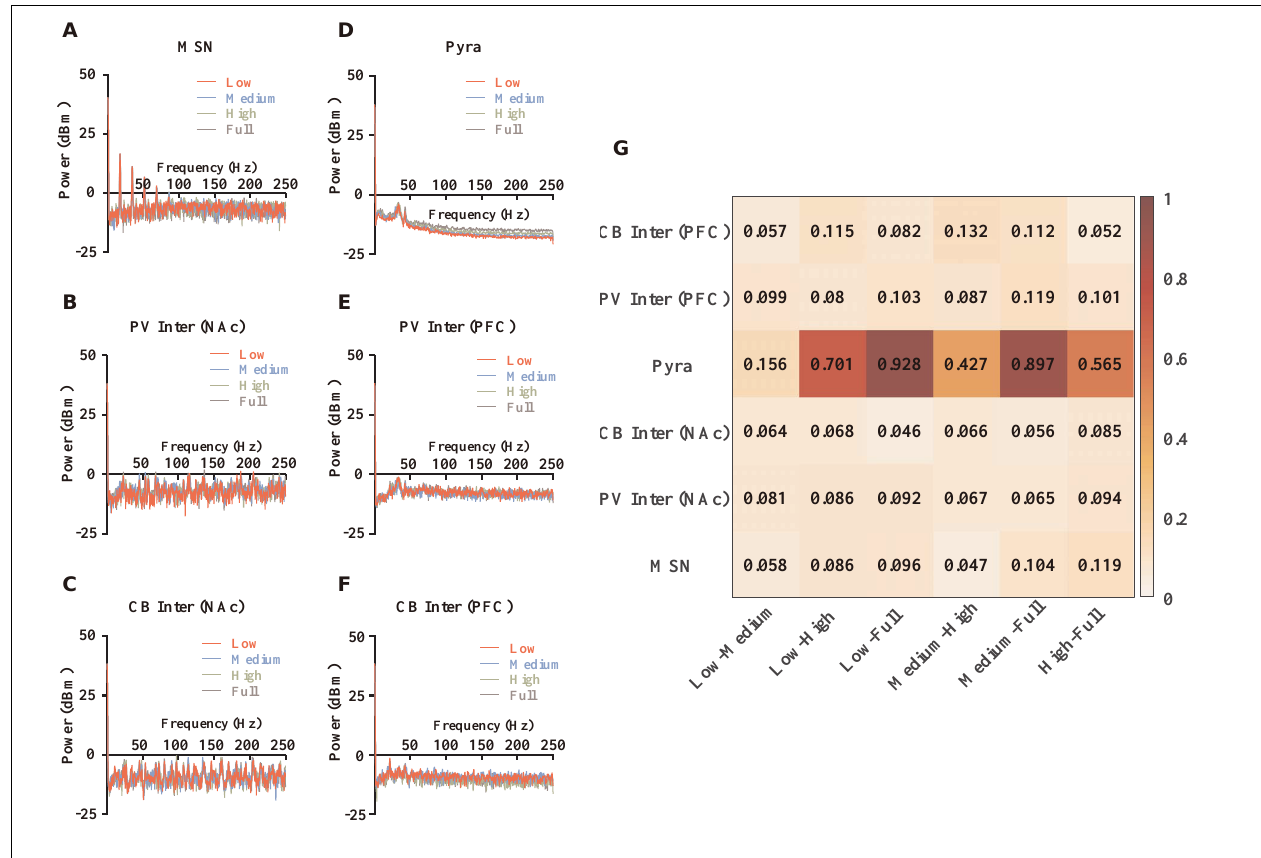
FIGURE 4 | Spectral analysis and statistical results. (A–F) Spectral results for different types of neurons, which were averaged over 9 independent replicated experiments. (G) The quantifications of the differences. The calculation method was described in section “Materials and Methods” (spectral analysis).